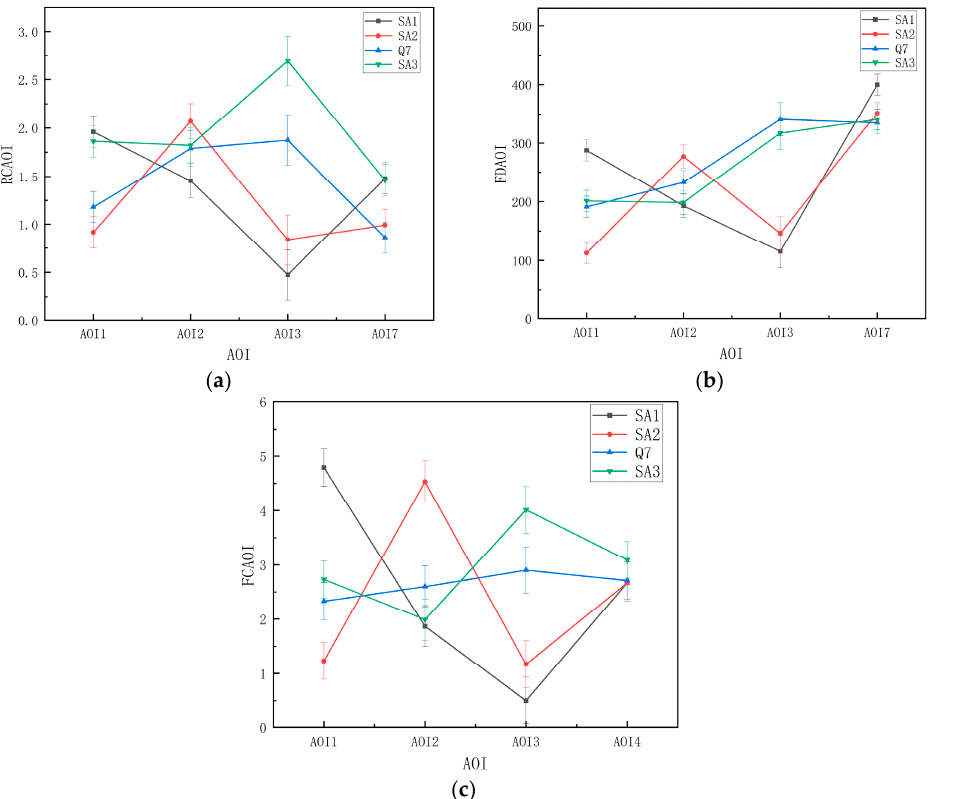
Figure 14. Interaction effect of attention allocation between the key AOIs and three stages of SA: ( a ) average regression count among key AOIs; ( b ) average fixation duration among key AOIs; and ( c ) average fixation count among key AOIs. Error bar: standard